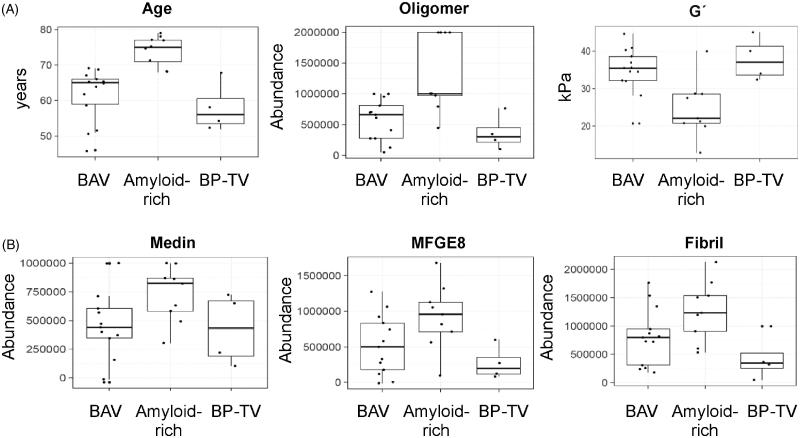
Boxplots of variables between the three groups. (A) Variables that show significant differences between the three groups as shown in Table 1 (bicuspid valve n = 13, bicuspid like phenotype-tricuspid valve n = 4, amyloid-rich n = 9). (B) Additional variables showing increased levels in the amyloid-rich group compared to the other two groups. Variable distribution is shown as boxes containing the interquartile ratio (first and third quantiles) with the median shown (bold line), whiskers represent the 5–95% range, respectively. Each point within the plot represents a patient sample for the variable specified.